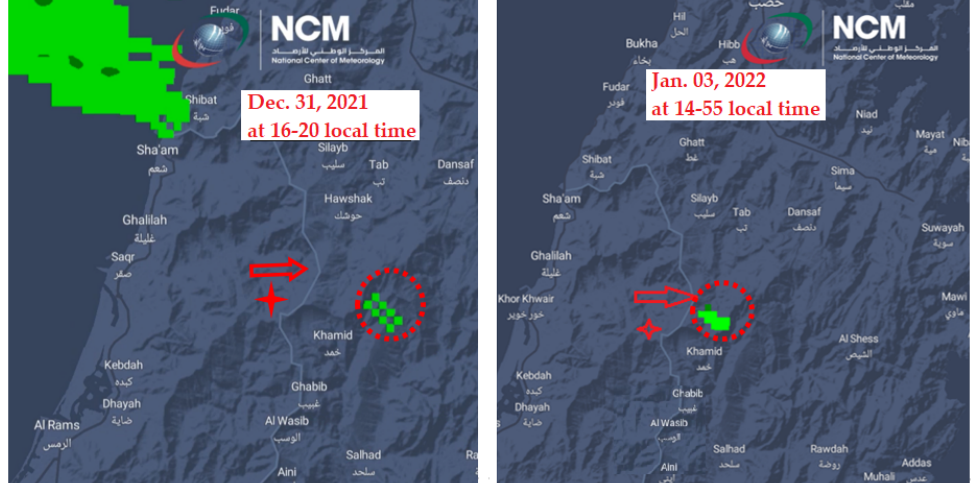
Figure 14. Radar maps with radar echo of artificial rain at 16–20 of local time, 31 December 2021, and 14–55, 3 January 2022. Here, red arrow—wind direction, hollow cross—field site location, and dotted circle—radar echo signature.